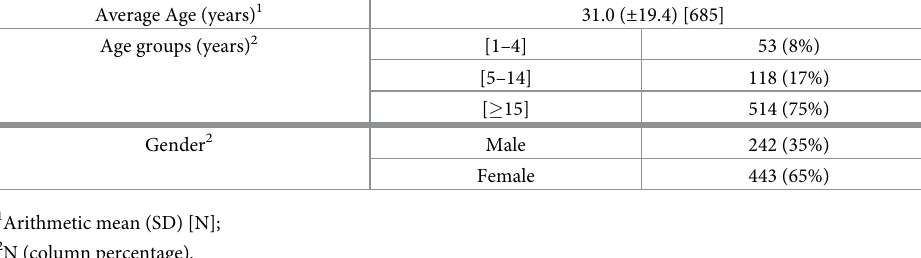
Table 1. Brief description of the population participating in the study.